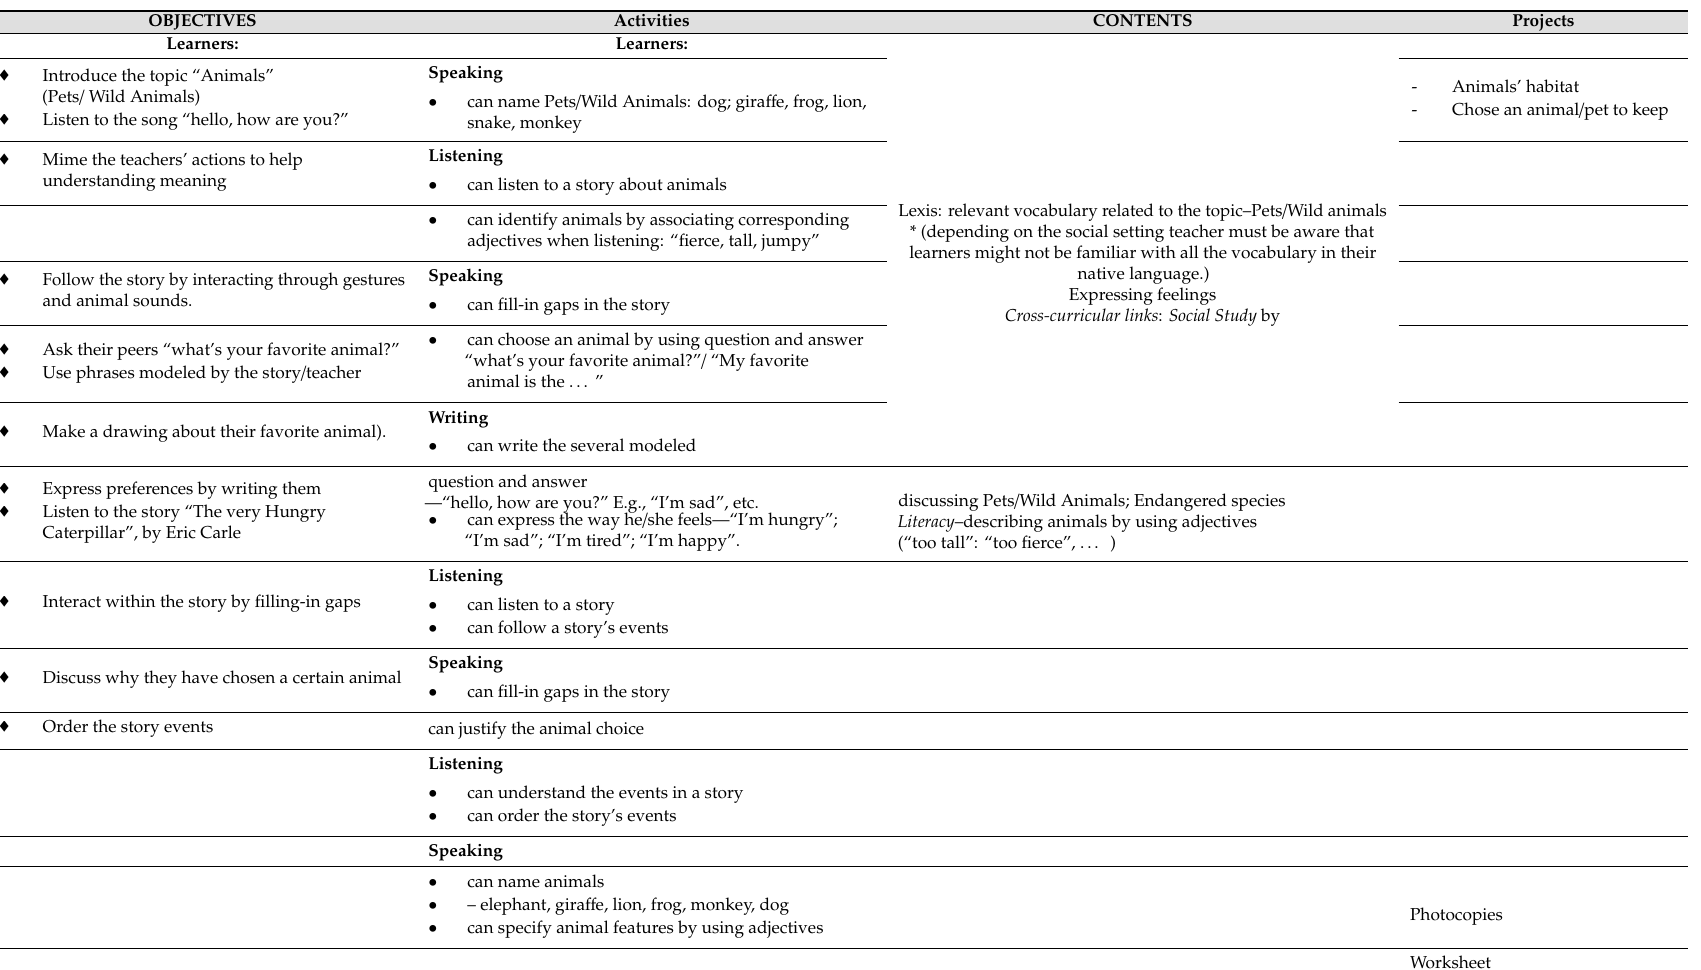
Table 2. Learning Unit: Science/Social Studies–sequencing activities.